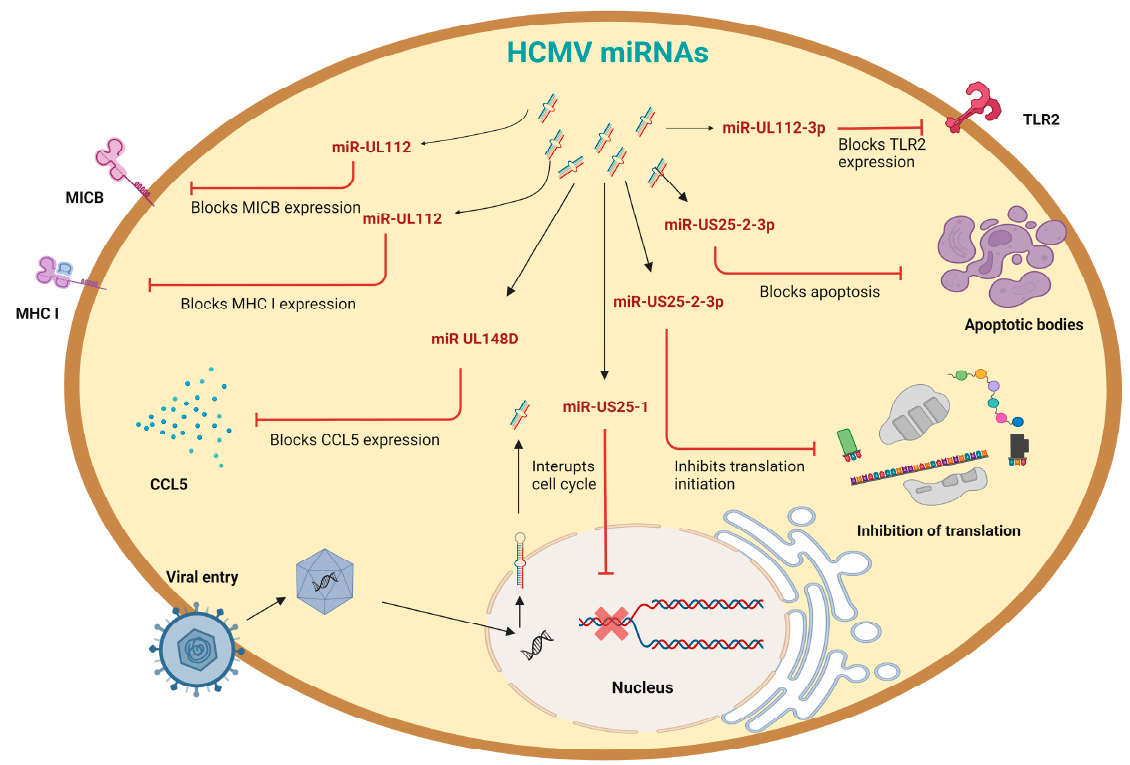
Figure 3. HCMV miRNA: A model representing the functional role of miRNAs produced by the human cytomegalovirus (HCMV) during its active replication cycle. Cellular receptors allow the virus to enter the cell, and the capsid then translocates to the nucleus, where it releases its genome. The lytic phase of HCMV infection produces miRNAs targeting multiple proteins in order to deregulate cellular signaling, gene expression, apoptosis, and innate immune response. HCMV-miR-US25-1 interrupts the cell cycle by targeting up to 20 cellular transcripts, including the collagenase stimulatory factor (CD147), cyclin E2 (CCNE2), and BRCA1/BRCA2- containing complex-subunit 3 (BRCC3) [13]. The levels of eukaryotic initiation factor 4A1 (eIF4A1), an RNA helicase that initiates translation, are downregulated by miR-US25-2- 3p, possibly promoting latency and cell-cycle control [74]. HCMV-miR-US25-1 targets the V0 subunit C pseudogene 1 (ATP6V0CP1) protein, an ATPase necessary in acidifying endosomal compartments. The regulation of this miRNA may be vital for controlling viral replication and avoiding the host immune system during the latent phase of the virus. HCMV-miR-UL112-1 targets the immediate early trans-activator, IE72, which is vital for the replication of viral DNA [75]. Additionally, miR-UL112-1 expresses the antisense form of the viral uracil DNA glycosylase (UL114), which promotes the production of both early and late viral transcripts [76]. Hence, when miR112-1 is expressed, viral replication is reduced, and viral latency is favored (Table